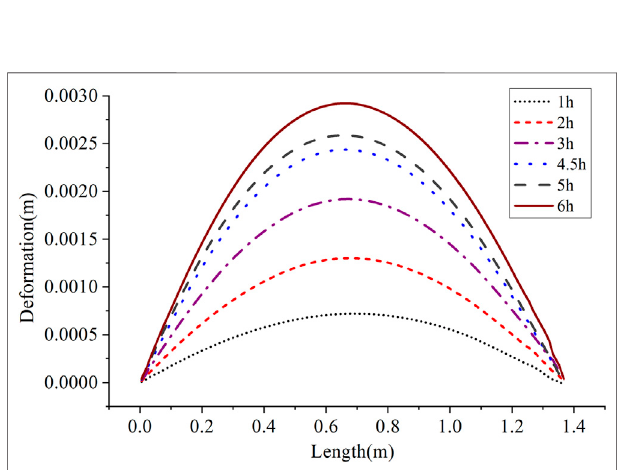
FIGURE 10 | Shape reconstructed by the 6 o ’ clock sensor.